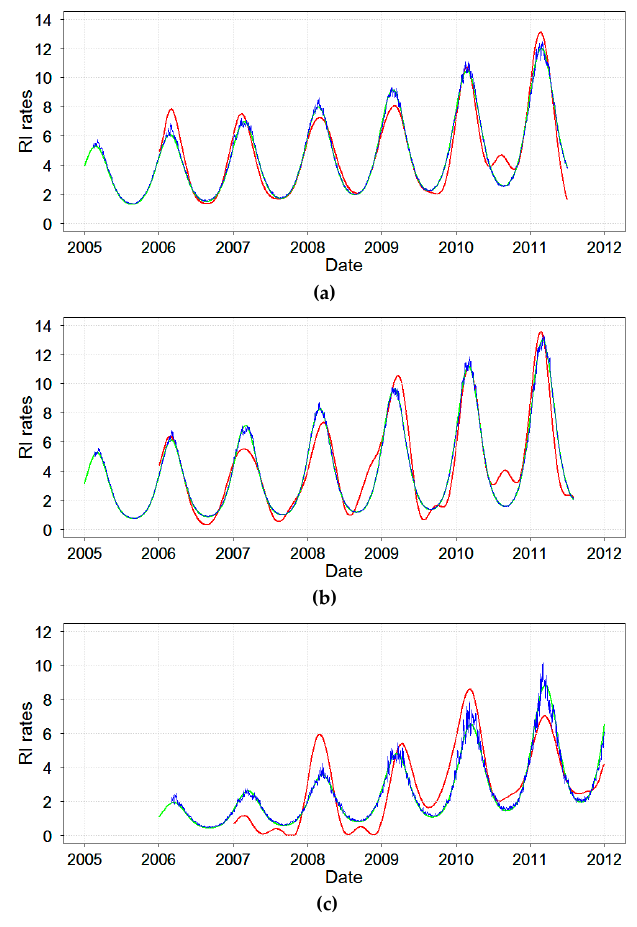
Figure 5. The predicted RI rates based on Model A (red line), Model B’ (green line), and Model C’ (blue line) in: ( a ) Chelyabinsk, ( b ) Yekaterinburg, and ( c ) Barnaul, Russia, 2005–2011.